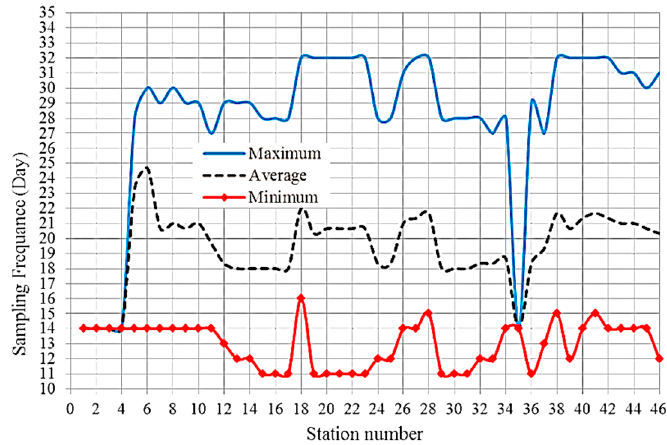
Figure 8. Minimum, average, and maximum interval of SF of the 46 MSs, with MA of ± 5%.